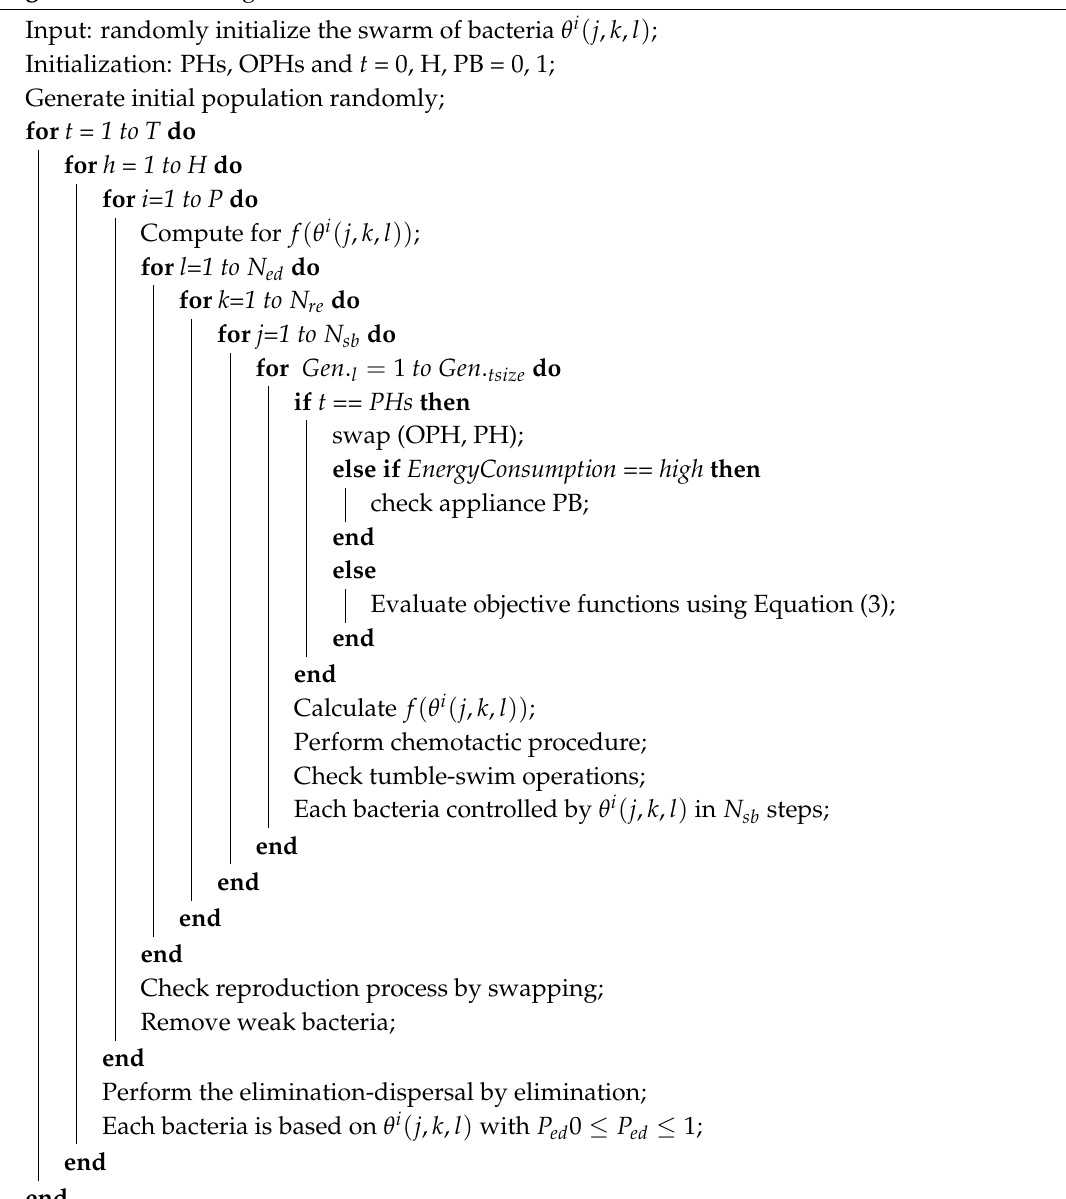
Algorithm 4: BFOA